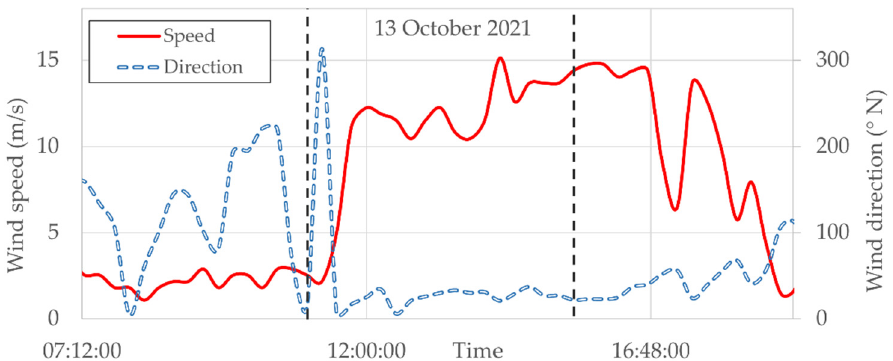
Figure 6. Wind speed and direction from a weather station near the selected